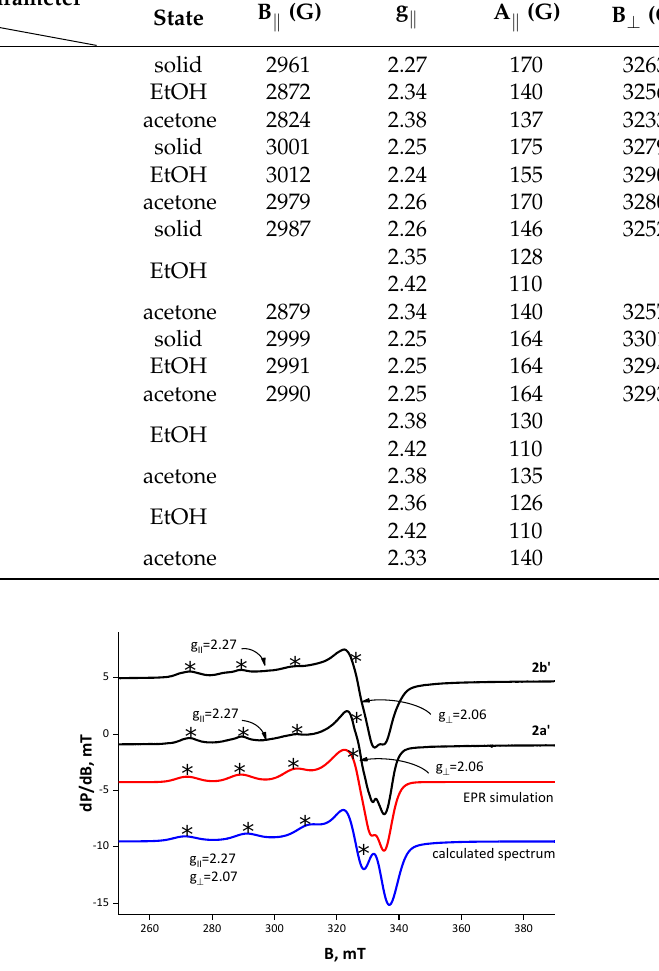
Figure 3. EPR spectra (in black) of the powder blue complexes 2a’ – b’ , 100 K. The simulated EPR spectrum (in red) and the DFT computed spectrum (in blue) are also presented. With asterisk * are labeled the lines of the hyperfine Cu 2+ structure.